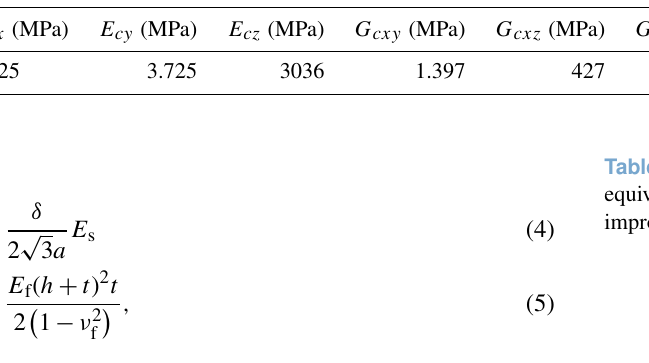
Table 4. Equivalent material parameters of the honeycomb core layer of the dynamically equivalent modeling method based on the laminated plate theory (ELM).